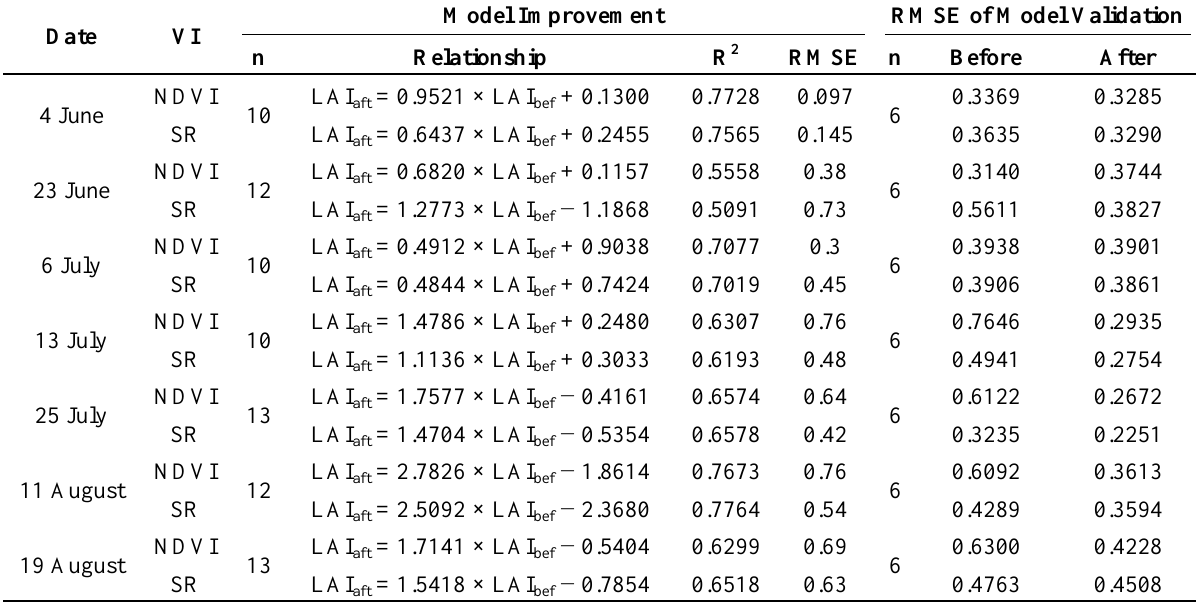
Table 2. Statistics of each scene’s model-improved HuanJing (HJ) satellite retrieved effective LAI